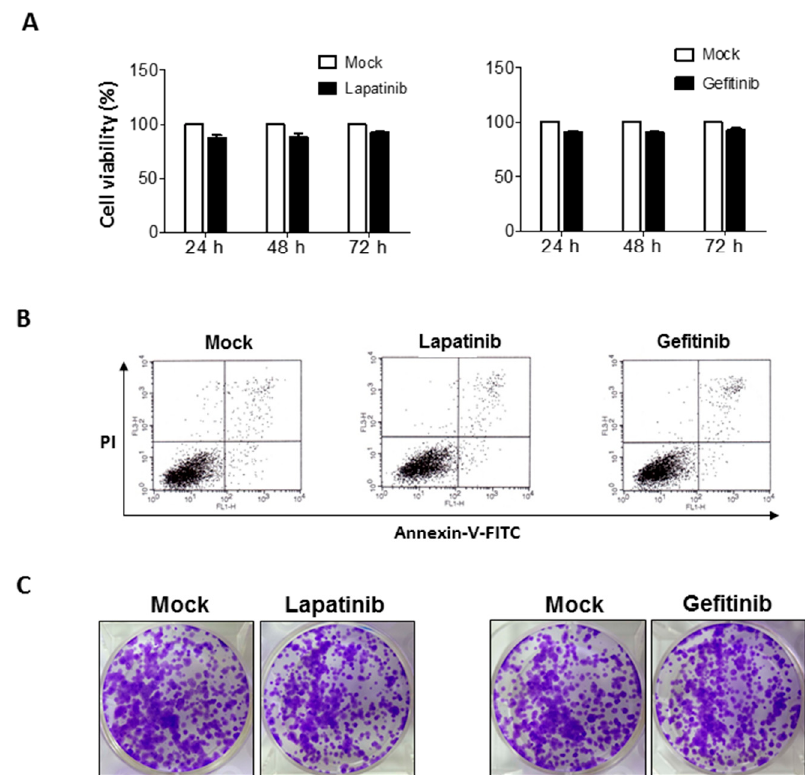
Figure 1. Limited effects of epithelial growth factor receptor (EGFR) inhibitors on T24 human bladder cancer cells. Evaluation of anti-cancer effects of lapatinib (5 µ M) and gefitinib (5 µ M) in T24 human bladder cancer cells by performing ( A ) a cell viability test at different treatment times (24, 48 and 72 h); and ( B ) flow cytometry analysis with annexin-V-FITC/PI double staining to determine apoptotic cell death after 24 h treatment of control or EGFR inhibitors; ( C ) limited efficacy of lapatinib (5 µ M) and gefitinib (5 µ M) in T24 human bladder cancer cells by performing the clonogenic assay. Colonies comprised of more than 50 individual cancer cells were visible and manually counted.